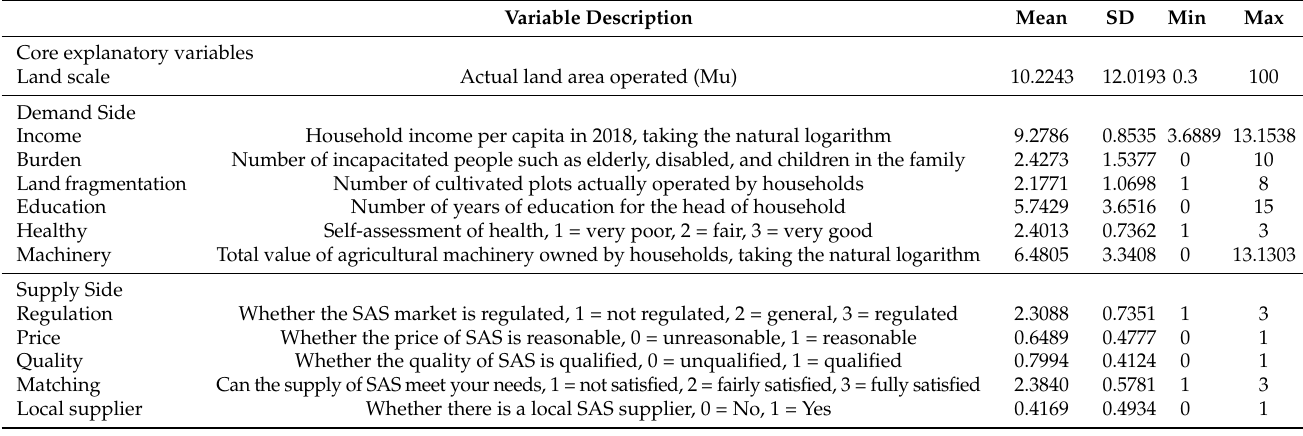
Table 3. Variables’